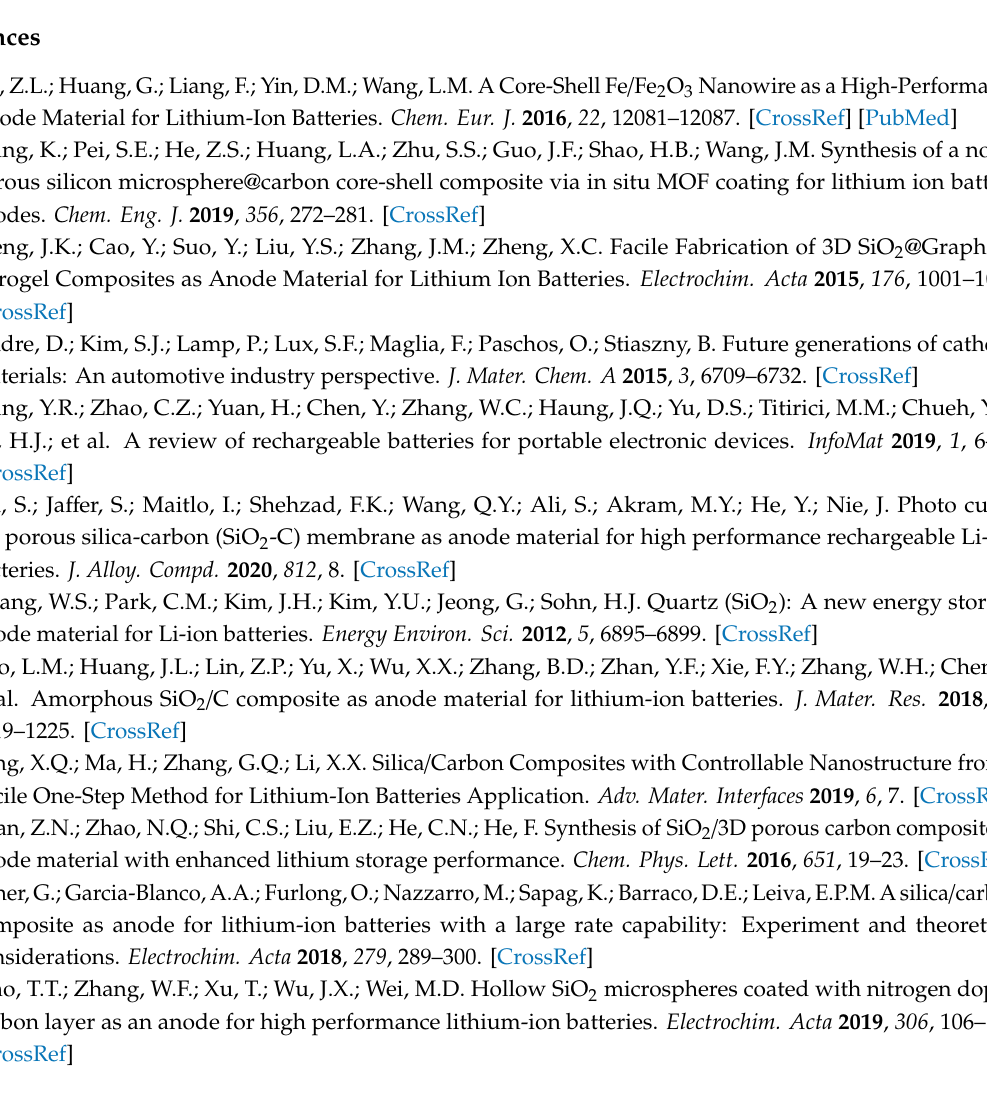
Figure S1: SEM images of (a) SiO 2 @CCNRs-2 and (b) SiO 2 @CCNRs-3. Particle size distributions of (c) SiO Figure S3: Plots of ω − 1 / 2 versus Z’ of SiO 2 @CCNRs composites anodes in